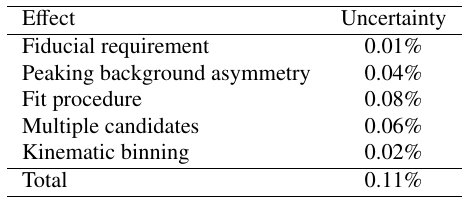
Table 1. Summary of absolute systematic uncertainties for ∆ A CP